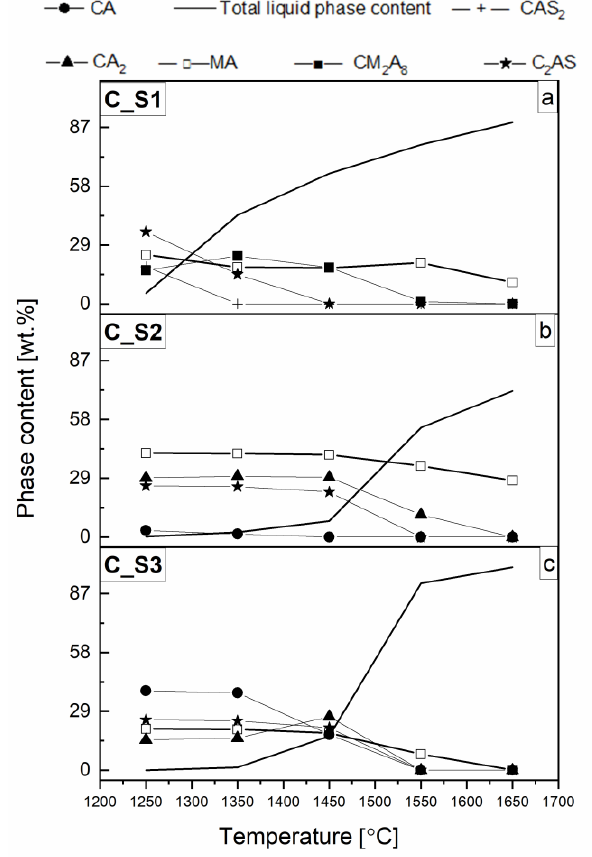
Figure 4. Thermodynamic predictions of the solid phases and liquid phase of the reactive mixtures containing components of the cement-free corundum-spinel refractory castable with 7 wt.% of MgO (castable C) and steel slags with the C/S mass ratio of 1.1_S1 ( a ), 3.5_S2 ( b ), 5.5_S3 ( c ), when exposed to an oxidizing atmosphere vs. increasing temperature.